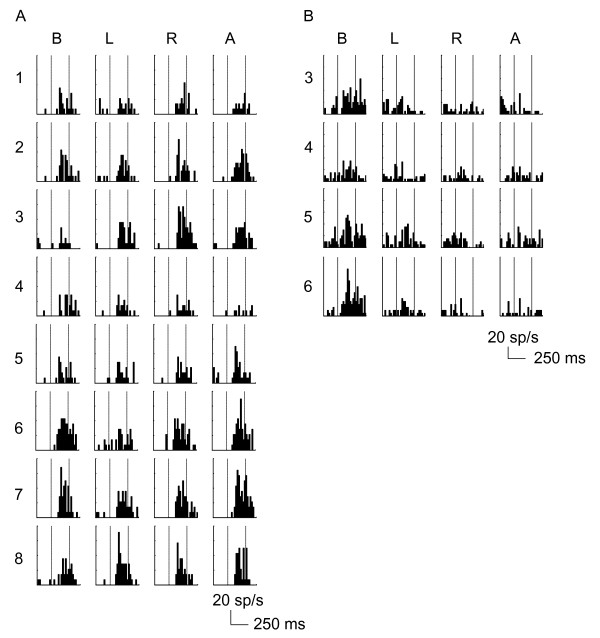
Selectivity of 2 V4 neurons to 3D shapes illuminated from different directions. Peristimulus time histograms from two V4 cells in response to the different combinations of 3D shapes and illumination directions. Each row corresponds to a given 3D shape and each column corresponds to a given illumination direction (Below, Left, Right and Above), respectively. Second and third vertical lines on each PSTH represent stimulus on- and offset (250 ms duration). (A) A Neuron which is highly selective for 3D shape but weakly for illumination direction (ANOVA, main effect, 3D shape; p < 0.001, illumination direction; p = 0.046). (B) A Neuron which is highly selective for illumination direction but less for 3D shape (ANOVA, main effect, 3D shape; p = 0.006, illumination direction; p < 0.001).